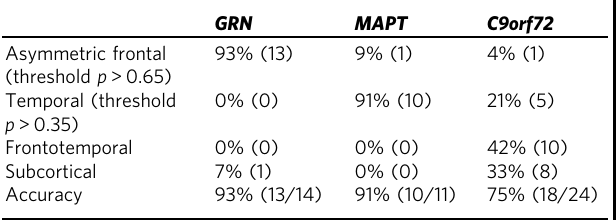
Table 2 As Table 1, but for subtypes obtained from a subtypes-only model that accounts for heterogeneity in disease subtype but not disease stage, i.e. the subtypes in Fig.